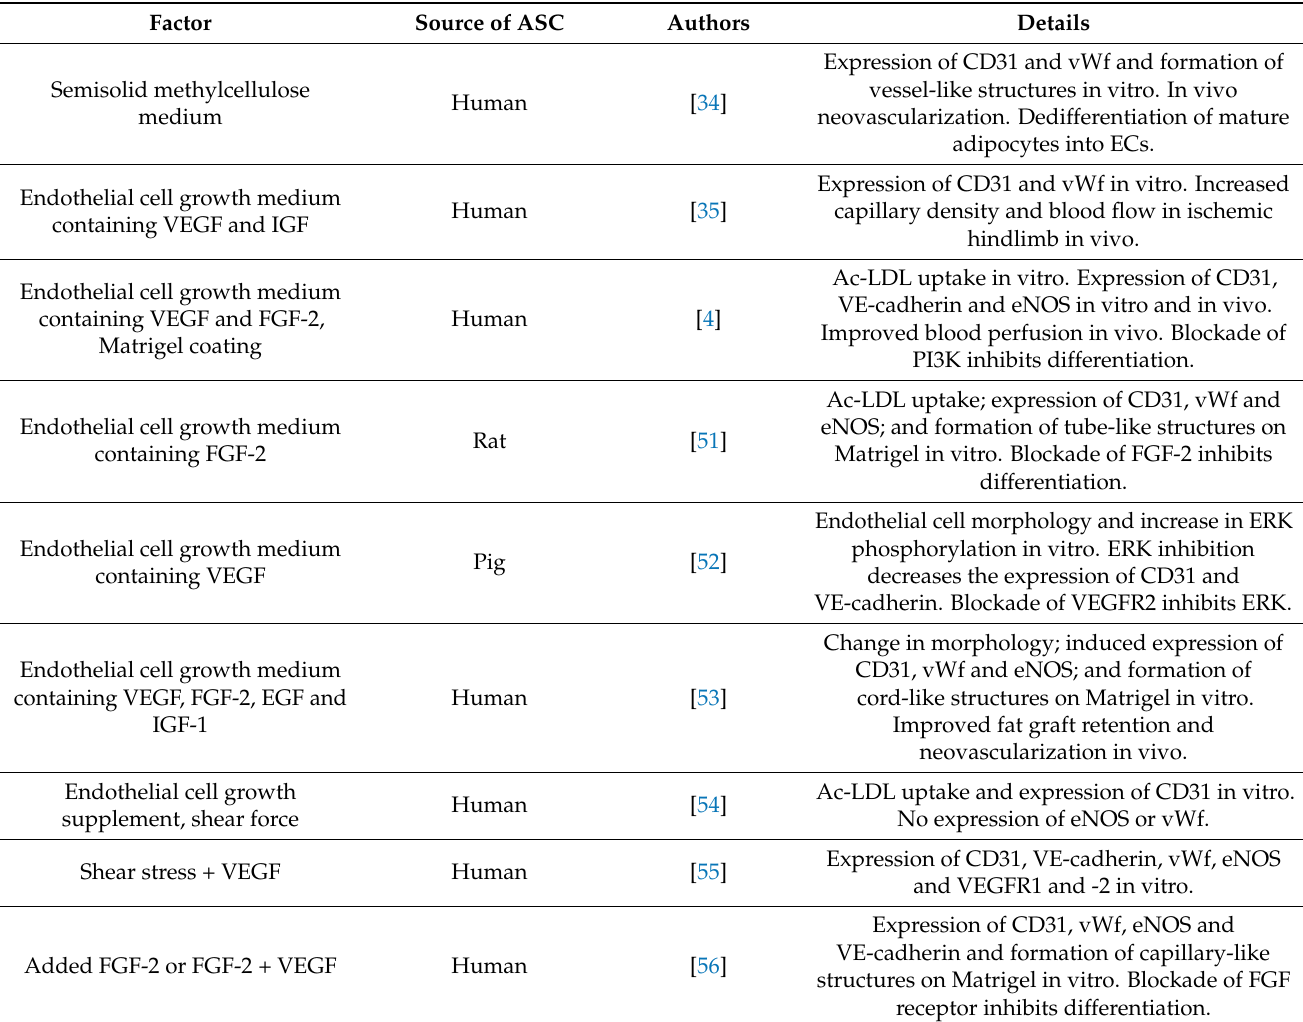
Table 1. Factors inducing ASC differentiation towards endothelial